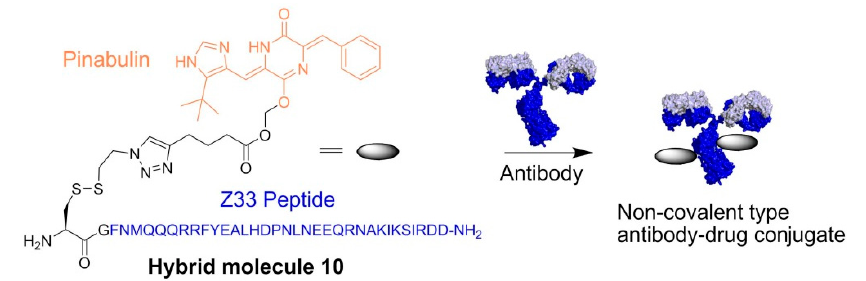
Scheme 1. Preparation of non-covalent antibody—drug conjugate using Pinabulin (cytotoxic agent) and Fc-binding peptide Z33.